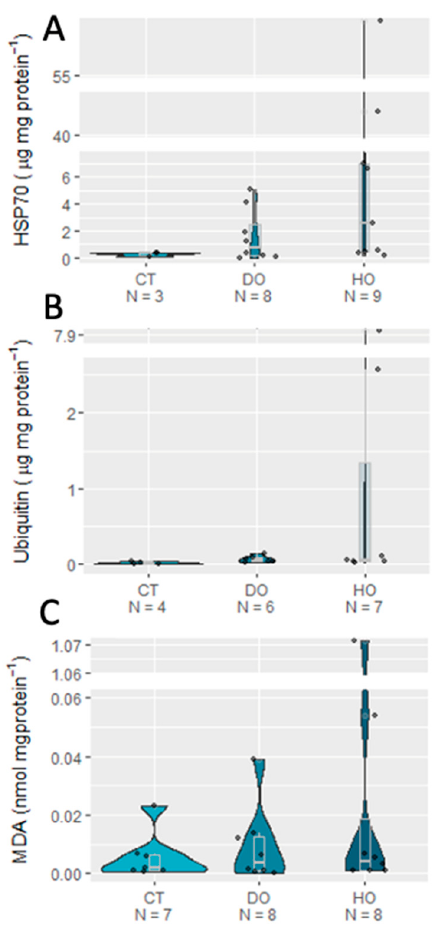
Figure 3. Effects of control (100% air saturation), deoxygenation (93% air saturation), and hypoxia (26% air saturation) on protein repair and elimination (HSP70 ( A ), Ub ( B ), and MDA ( C )) of S. canicula embryos exposed to experimental treatments (CT _ Control, DO _ Deoxygenation, and HO _ Hypoxia).